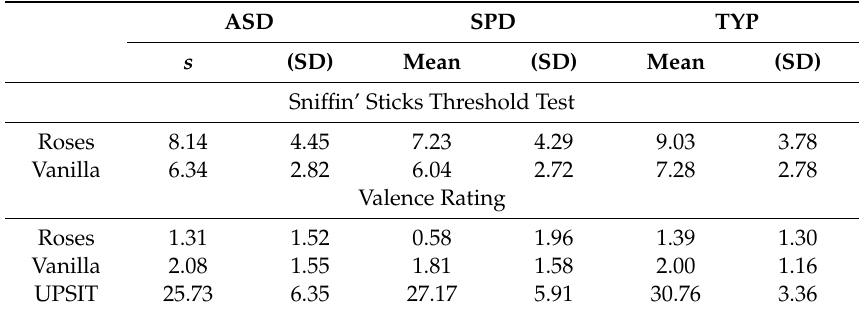
Table 2. Olfactory function by group.